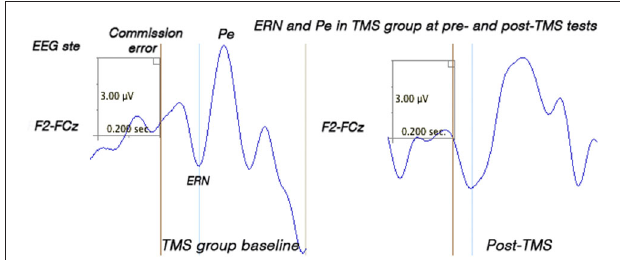
FIGURE 7 | Error-related Negativity (ERN) and Positivity (Pe) from the fronto-central midline EEG sites. Grandaverage waveforms at the fronto-central site (between F2 and FCz, N = 26 per group) show more negative amplitude and shorter latency of the ERN in the TMS group post-treatment. ERN peak occurring within 40–140 ms post-error is marked by a blue line.